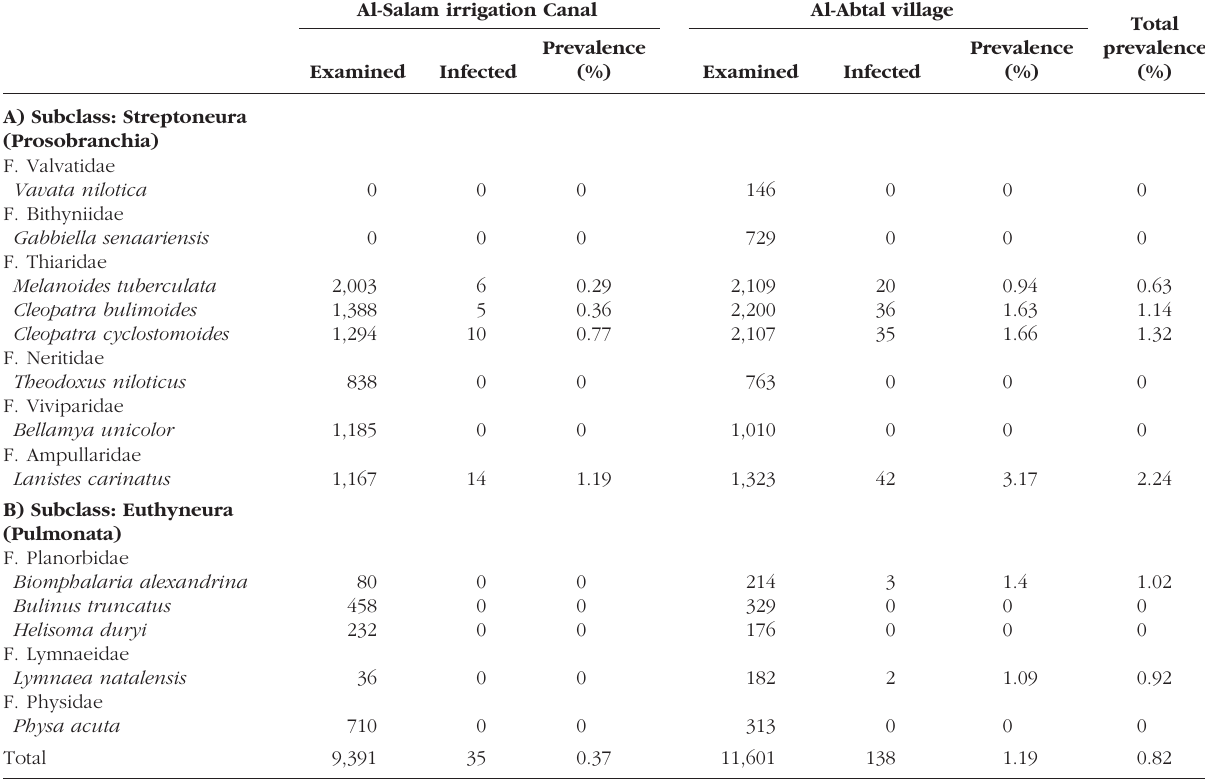
Table I. – Numbers and types of examined snails for prevalence (%) of P. cantonensis larvae in the study area (Al-Salam Canal and Al- Abtal village, new cultivated area in north